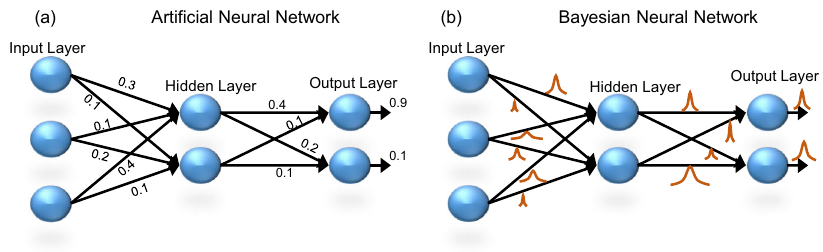
Fig. 1 | Comparison ofanarti fi cialneuralnetwork (ANN) and a Bayesianneural network (BNN). Schematic of a an ANN and b a BNN. The synapses of ANN